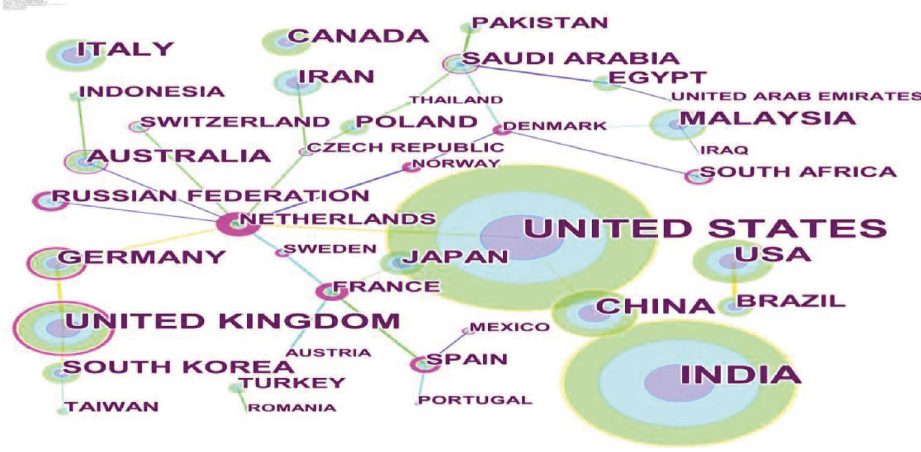
Figure 35: Country/region network for review articles. Table 2: Top 9 keywords with the strongest citation burst for review